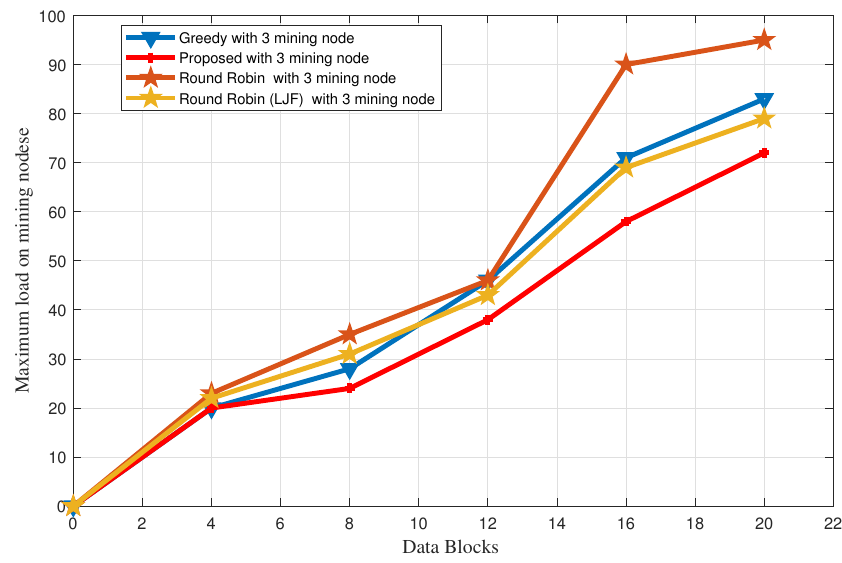
Figure 4. Number of computed nonce against a varying number of data block requests.